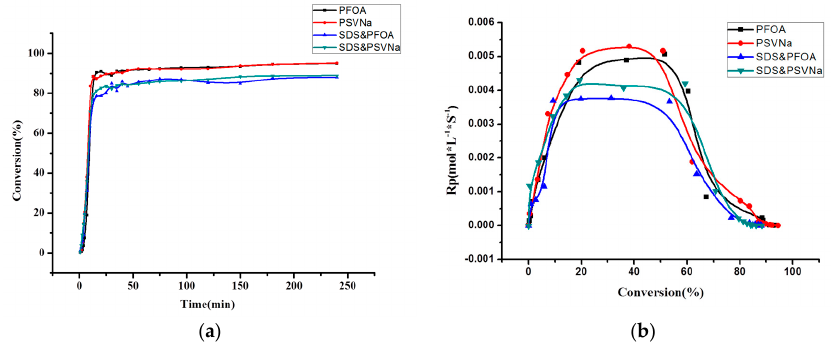
Figure 7. ( a ) Variations of conversion with time for different emulsifier. ( b ) Variation of R p with conversion for different emulsifier.